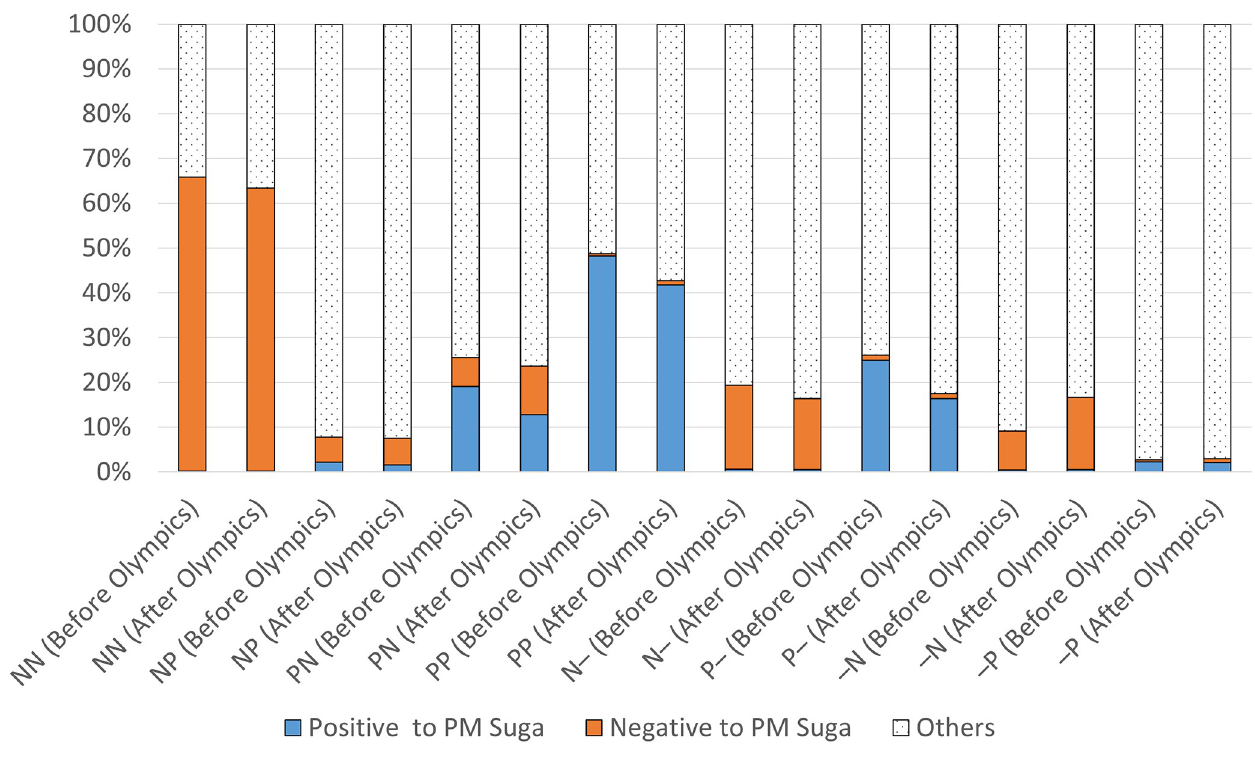
Fig 2. Associations of attitudinal changes toward the Olympic Games and PM